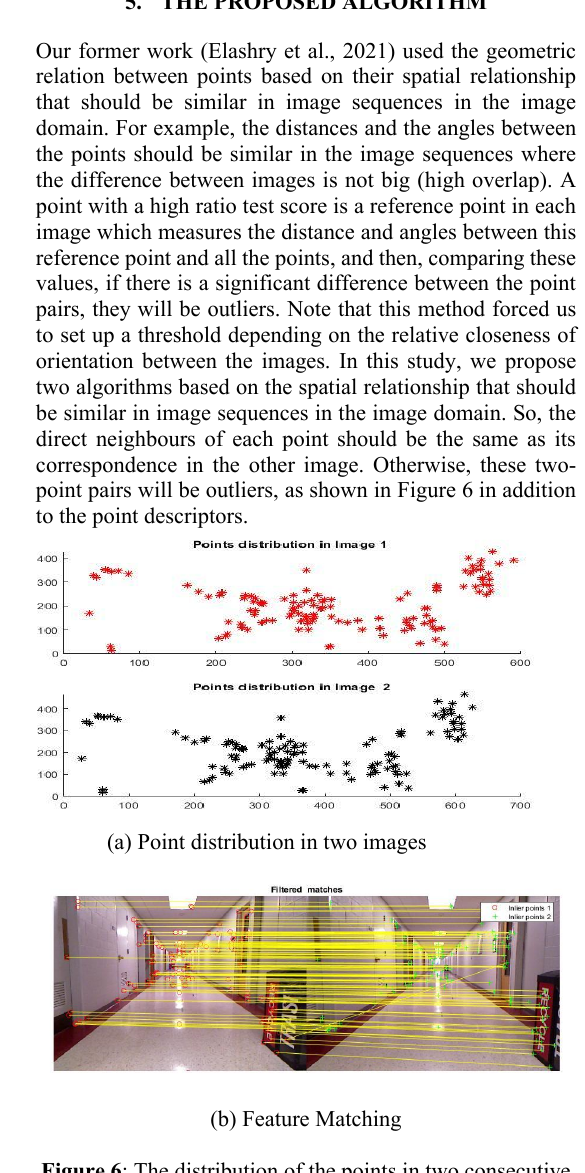
Figure 6 : The distribution of the points in two consecutive images and their feature matching